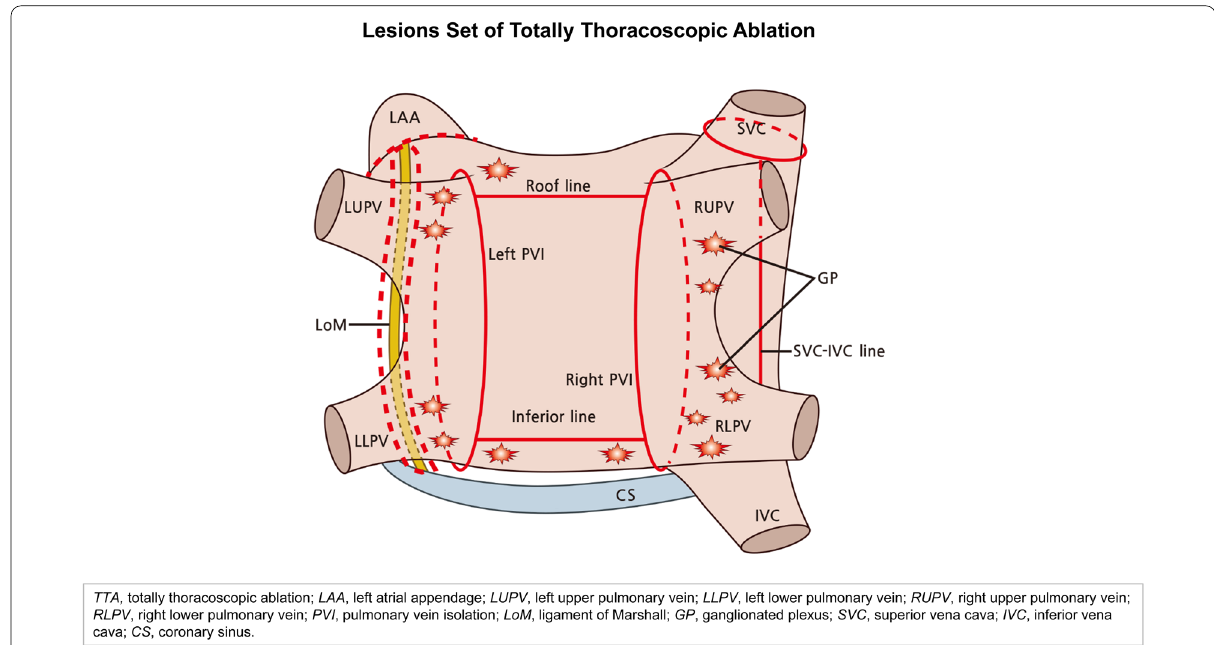
Fig. 2 Lesions set of totally thoracoscopic ablation of atrial